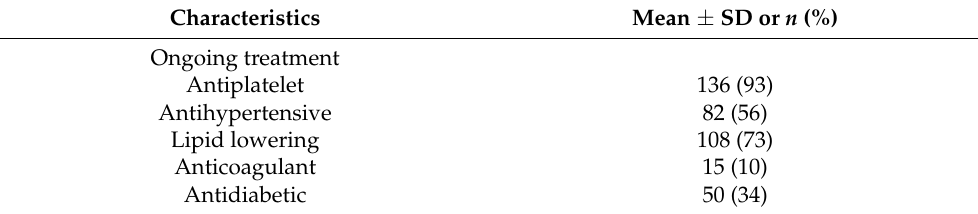
BMI = body mass index; CVD = cardiovascular disease.